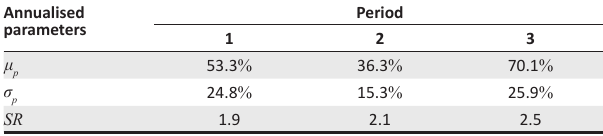
FIGURE 6: Efficient frontiers of portfolio C, a combination of all the metals within portfolios A and B, during periods 1, 2 and 3. TABLE 1: Summary of portfolio A tangent portfolio performance during periods 1, 2 and 3.